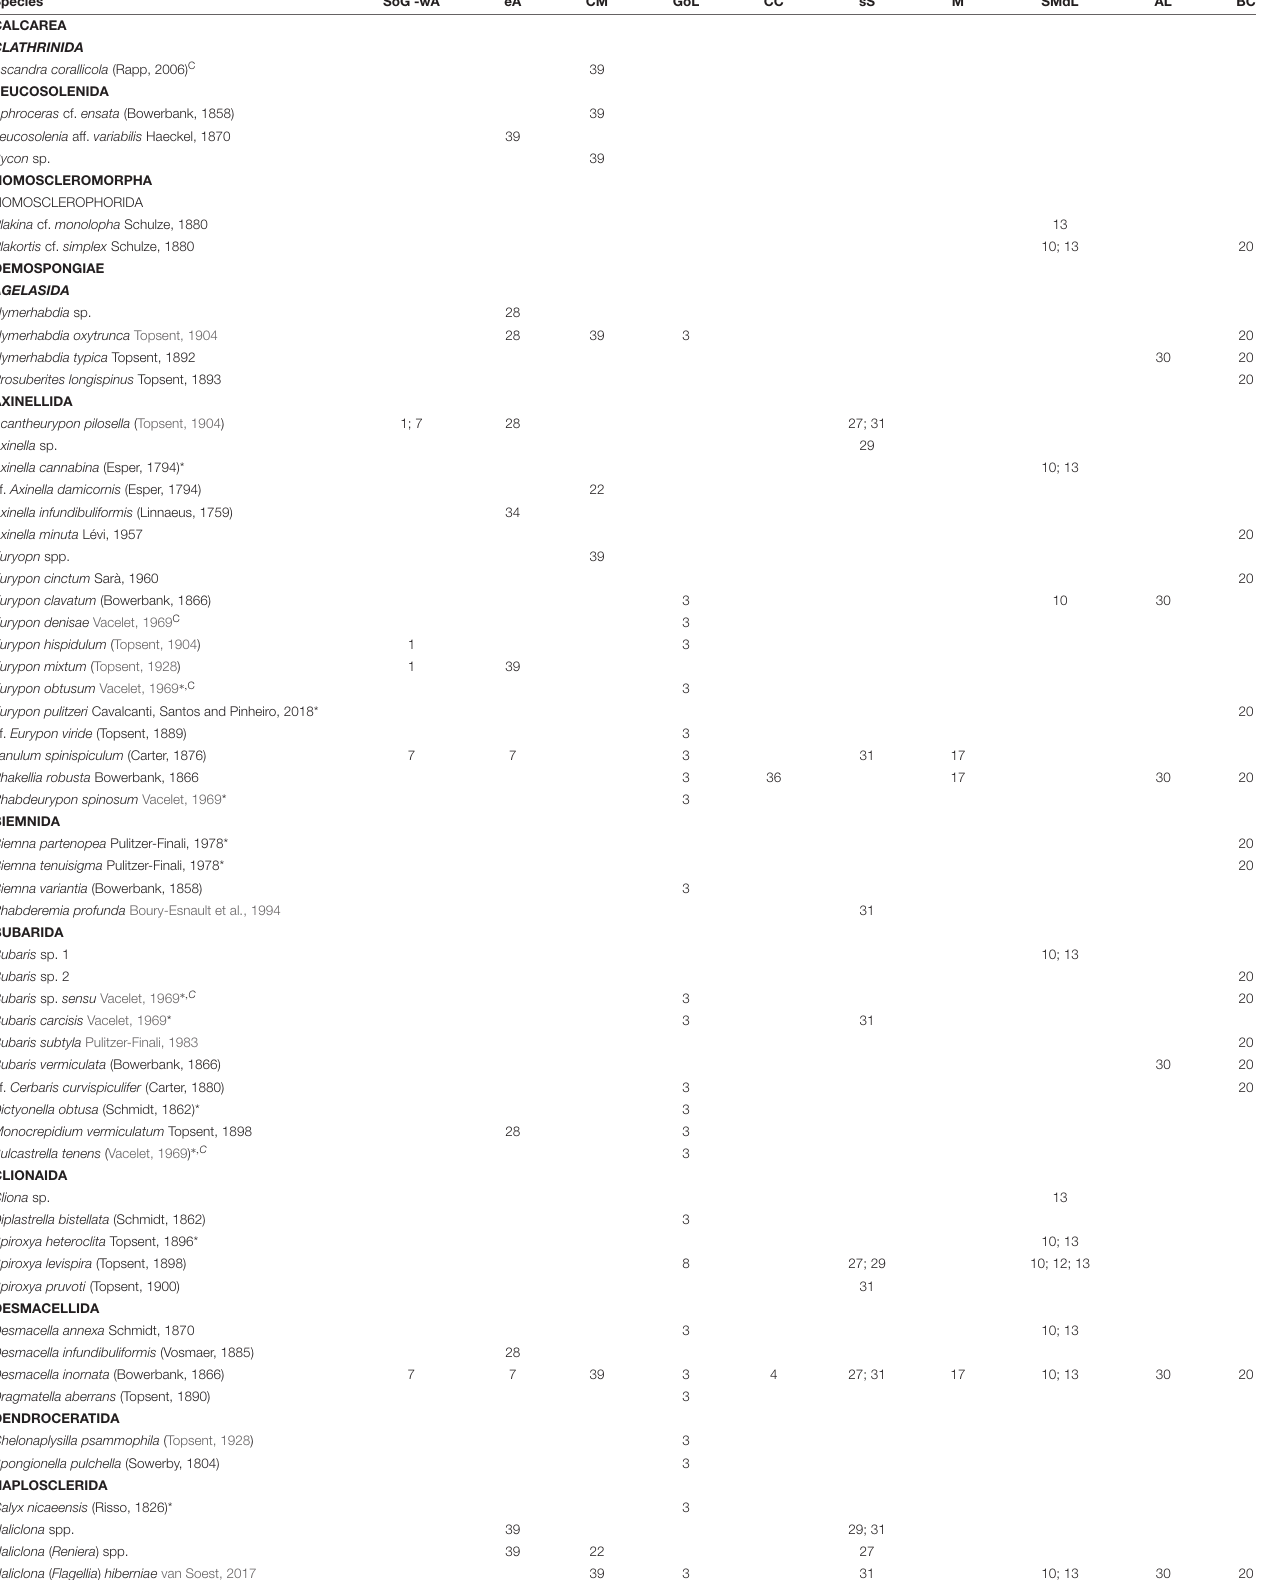
TABLE 1 | Comparative table including all known sponge species that have been recorded within CWC provinces in the Mediterranean Sea. Species SoG